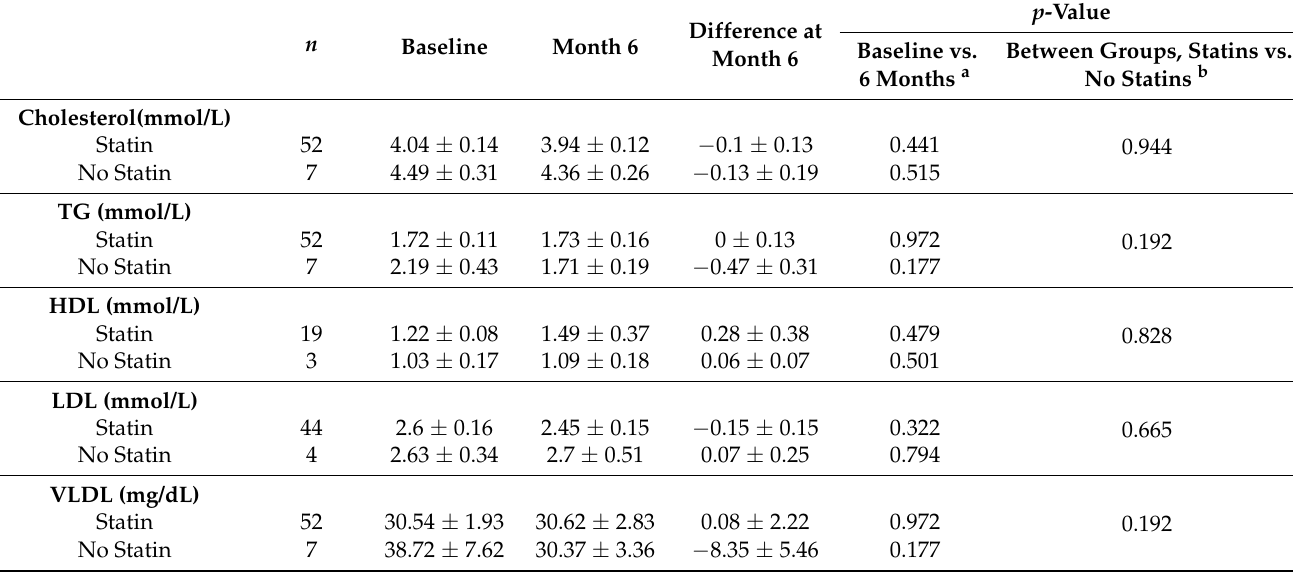
Table 4. Changes of lipid profile levels from the baseline to 6 months duration of GLP-1RA treatment in type 2 diabetes mellitus subjects.